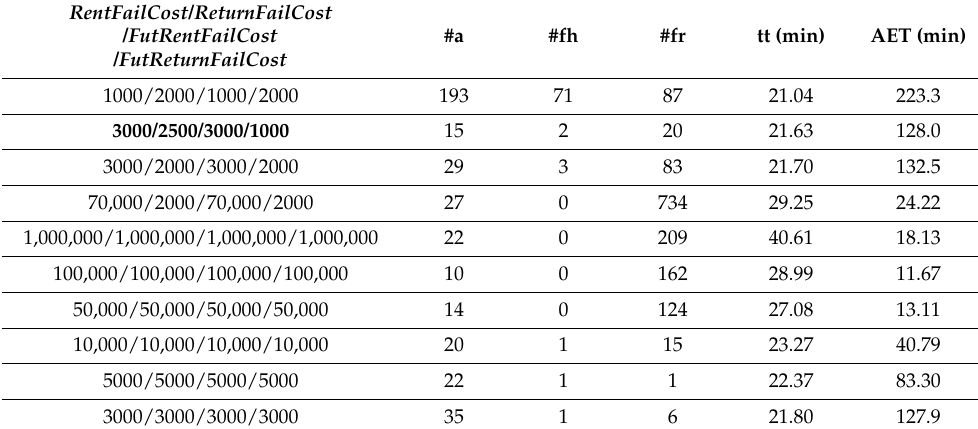
Table 4. Experimental results for Madrid. Bold numbers indicate the best obtained result for each metric.